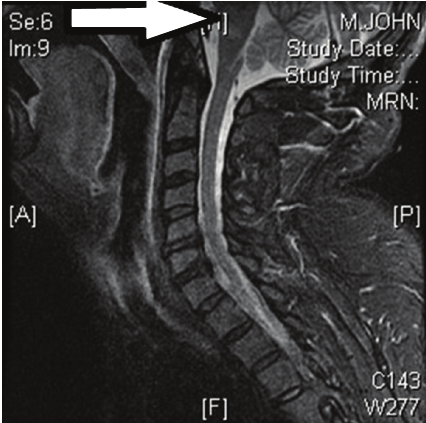
Figure 3: MRI of cervical spine, sagittal, shows abnormal T2 hyperintense lesion at mid-upper medulla.